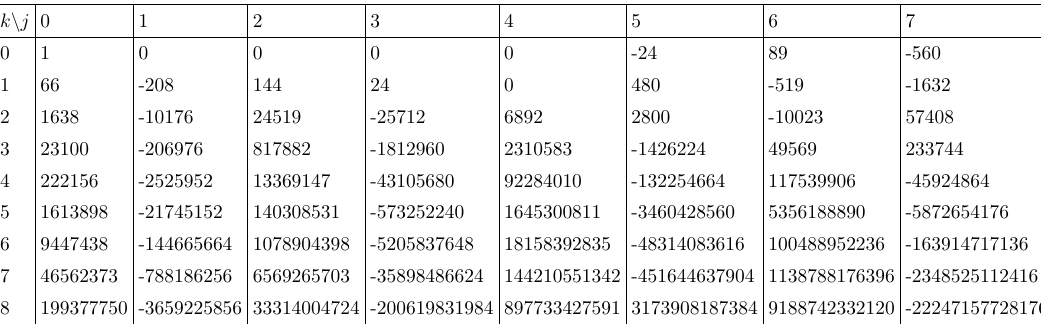
Table 61. Table of b jk coe(cid:14)cients for h SO(12) b